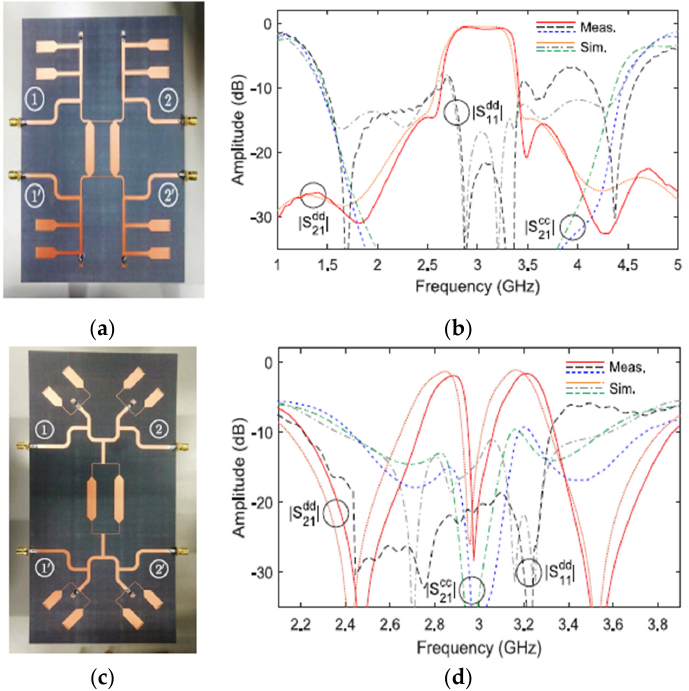
Figure 2. The proposed differential planar filters [44]: ( a ) Single-band filter configuration; ( b ) Single-band simulation and measurement results; ( c ) Dual-band filter configuration; ( d ) Dual-band simulation and measurement results.